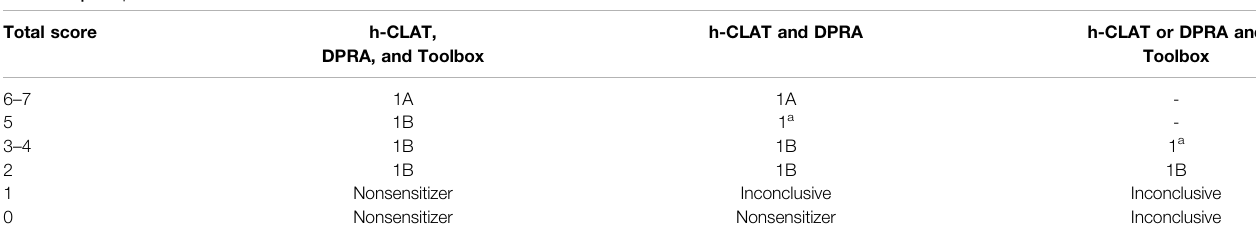
TABLE 3 | Interpretation of total ITSv2